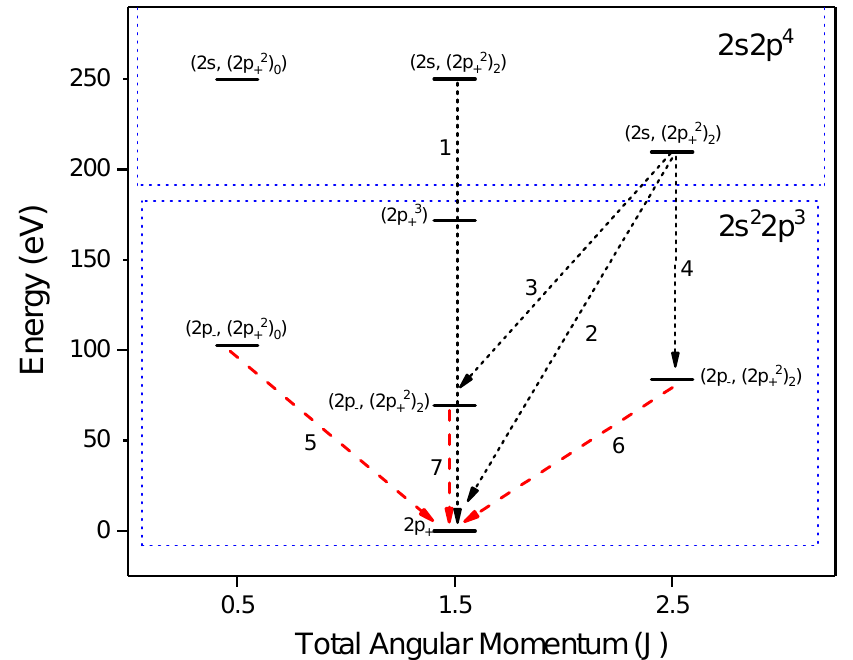
Figure 8. Partial Grotrian diagram of the ground state and first lowest excited configurations of N-like yttrium. The number labels in increasing order from 1–7 correspond to the lines at 4.9858(6) nm, 5.9329(4) nm, 8.8822(7) nm, 9.9054(10) nm, 12.0926(6) nm, 14.8036(5) nm and 17.8665(6) nm, respectively. Only three of the energy levels for the 2 s 2 p 4 configuration are shown. The dashed red lines correspond to magnetic dipole (M1) transitions, and the dotted black lines correspond to electric dipole (E1)